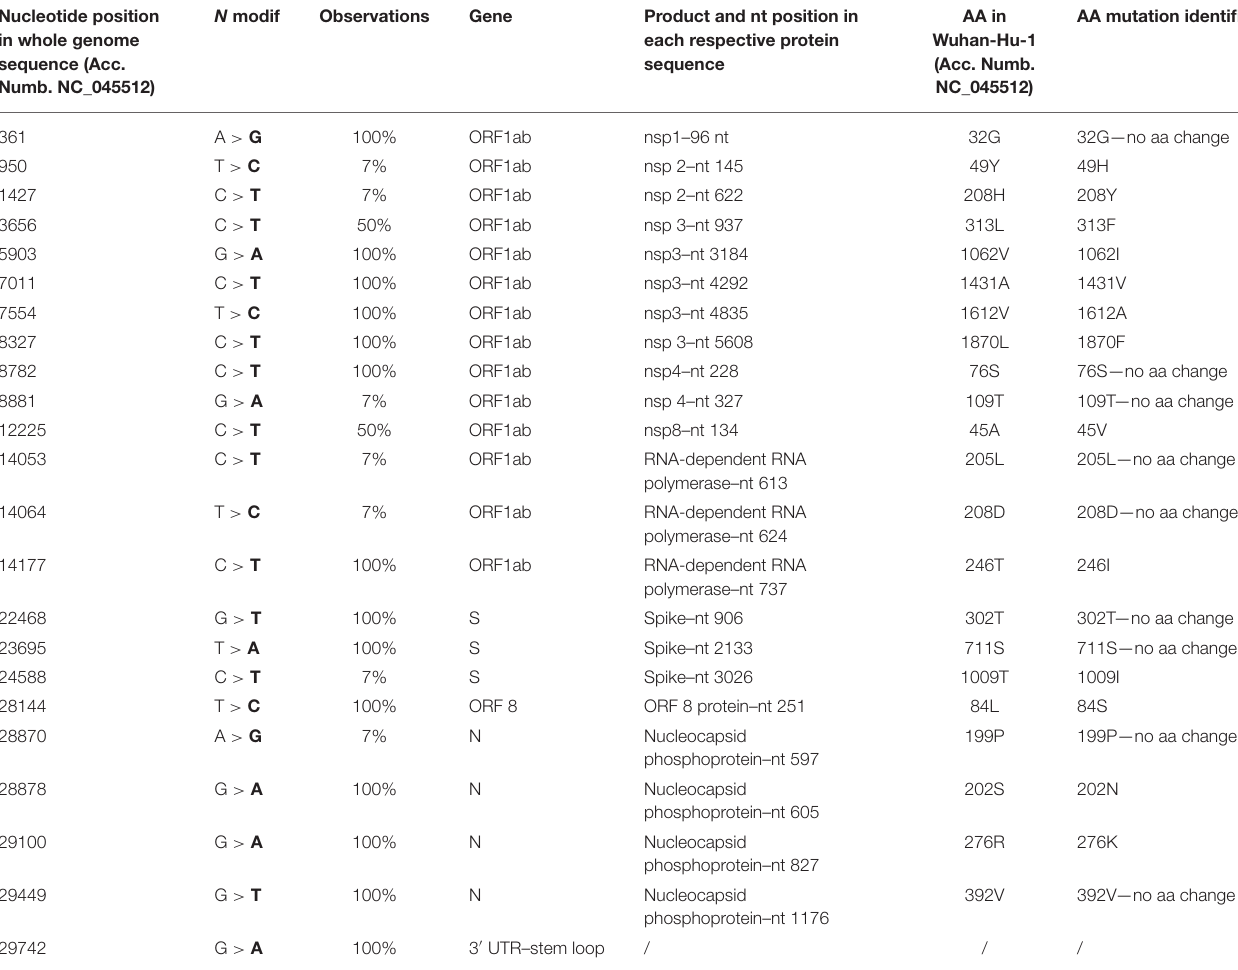
FIGURE 2 | (EPI_ISL_451195). The ISO alpha-2 codes (www.iso.org) were used at the end of the taxon names to refer to each country. An asterisk along the branches represents an aLRT–aBayes support ≥ 0.99 (Bayesian-like transformation of aLRT available from Phyml software) for the clade subtending that branch.